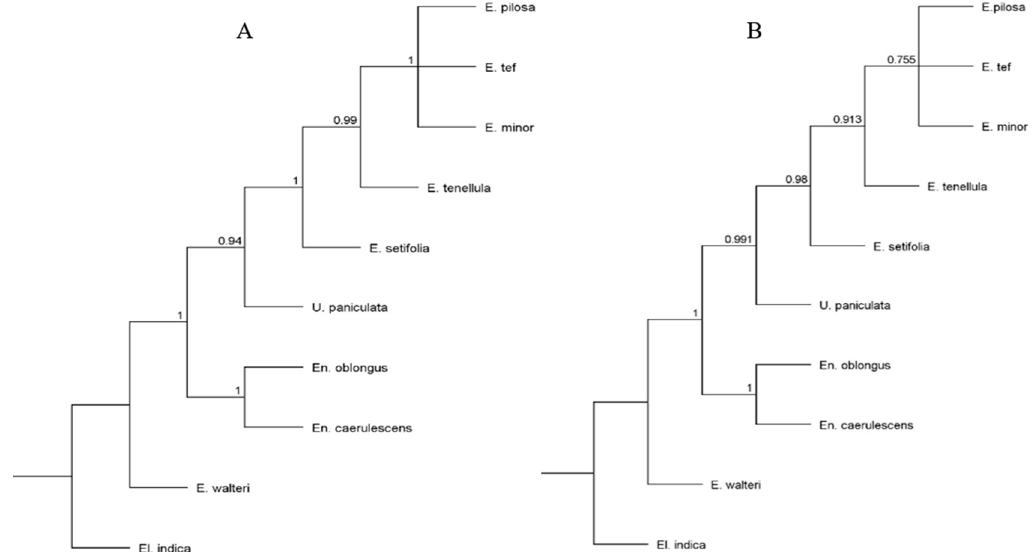
Figure 8. Phylogenetic trees based on divergence region and protein coding genes. ( A ) BI tree based